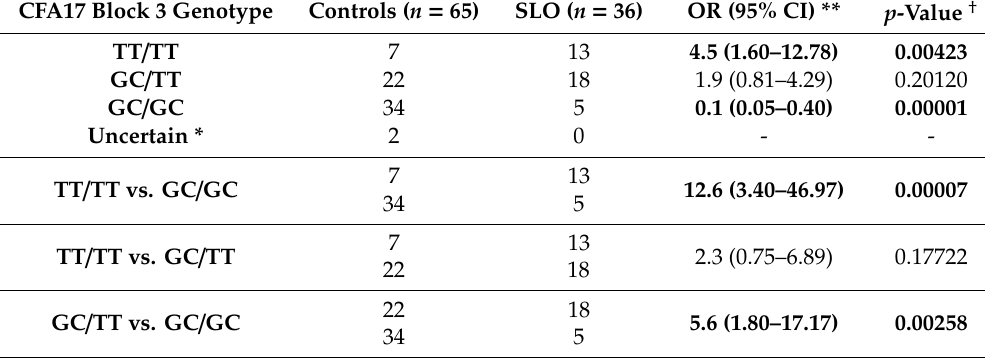
Table 2. Odds ratio (OR) for CFA17 block 3 genotypes (17:45,646,810–45,660,242) in 101 Bearded Collies (36 SLO, 65 controls). The bolded values were statistically significant at p < 0.05.